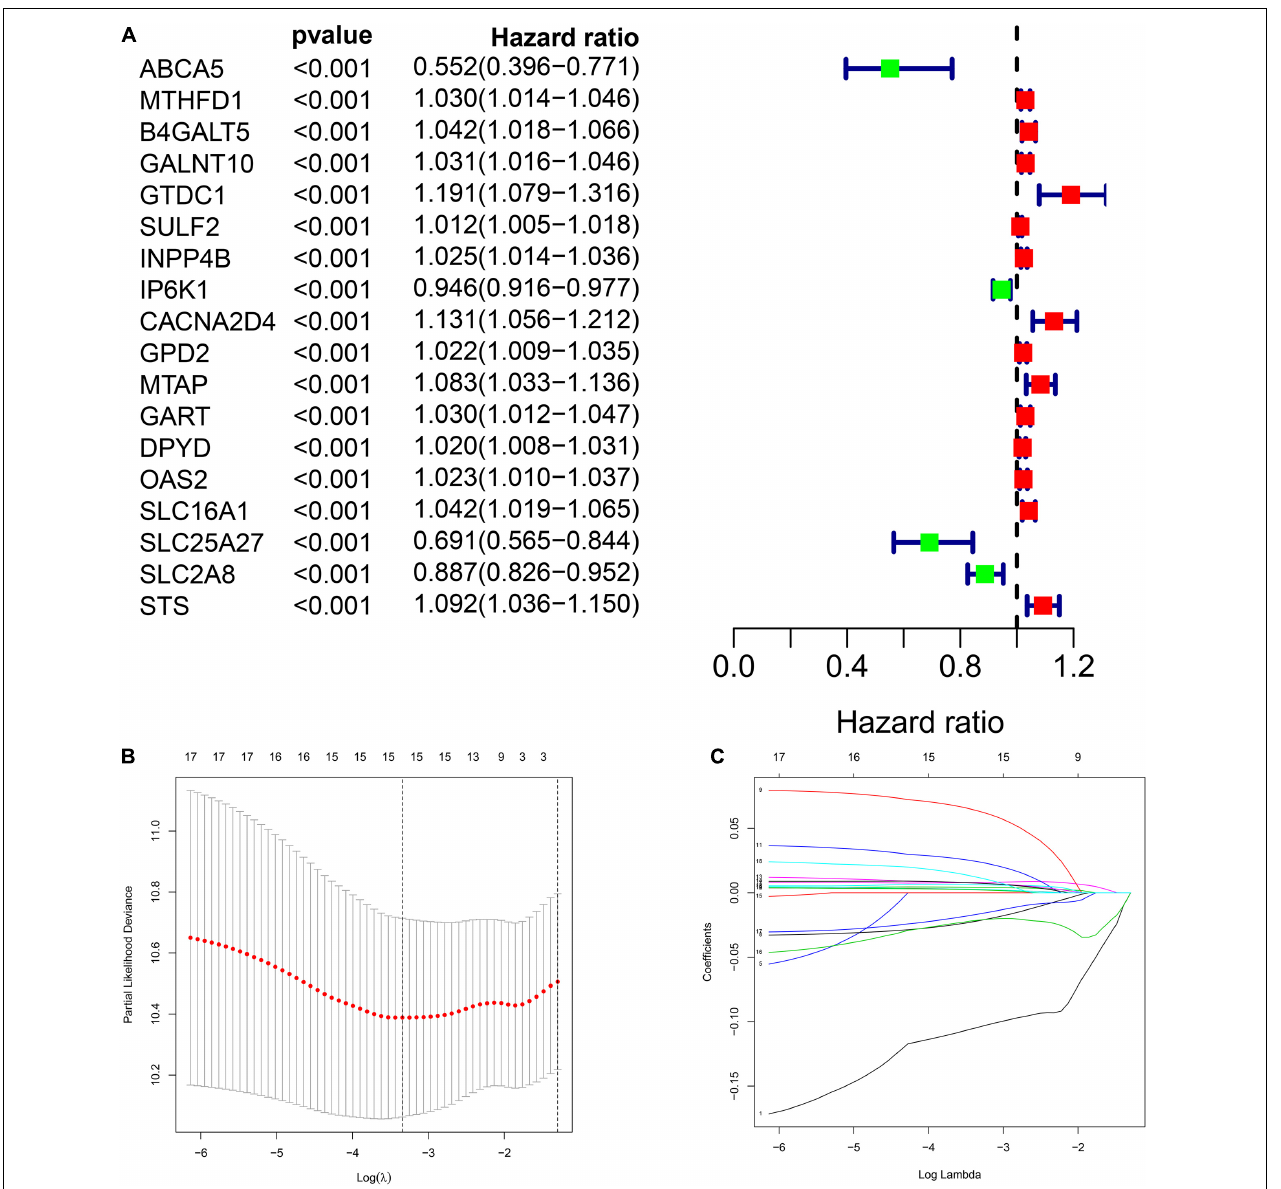
FIGURE 3 | Construction of metabolic prognostic model in The Cancer Genome Atlas (TCGA) cohort. (A) Forest plot of prognostic DMRGs. (B,C) Lasso regression